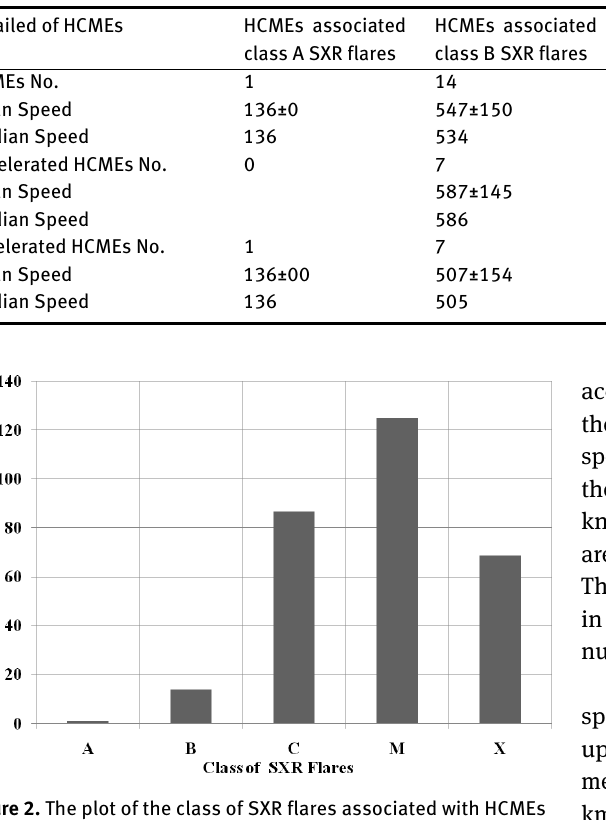
Figure 2. The plot of the class of SXR flares associated with HCMEs versus the number of HCMEs associated with SXR